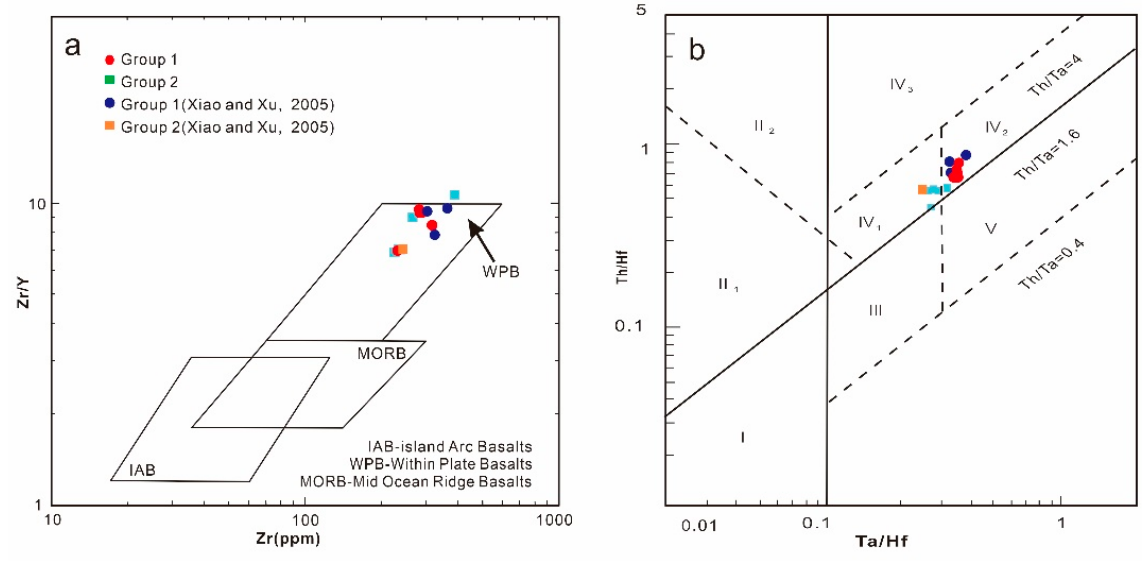
Figure 12. Tectonic discrimination diagrams for Dashibao basalt in the Xindianzi area. ( a ) Zr/Y- Zr [46], ( b ) Ta/Hf–Th/Hf diagram [47]. I. Plate divergent margin MORB; II1. Ocean island-arc